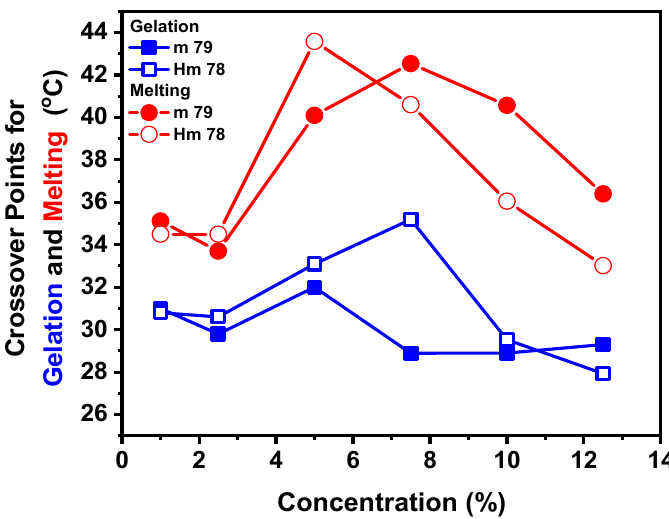
) and gelation ( (cid:4) , (cid:3) ) procedures vs the concentration for Figure 9. The crossover point for melting ( ● , ○ ) and gelation ( ■ , □ ) procedures vs the concentration (cid:35) m79 (solid symbol) and Hm78 (open symbol) for m79 (solid symbol) and Hm78 (open symbol) solutions.